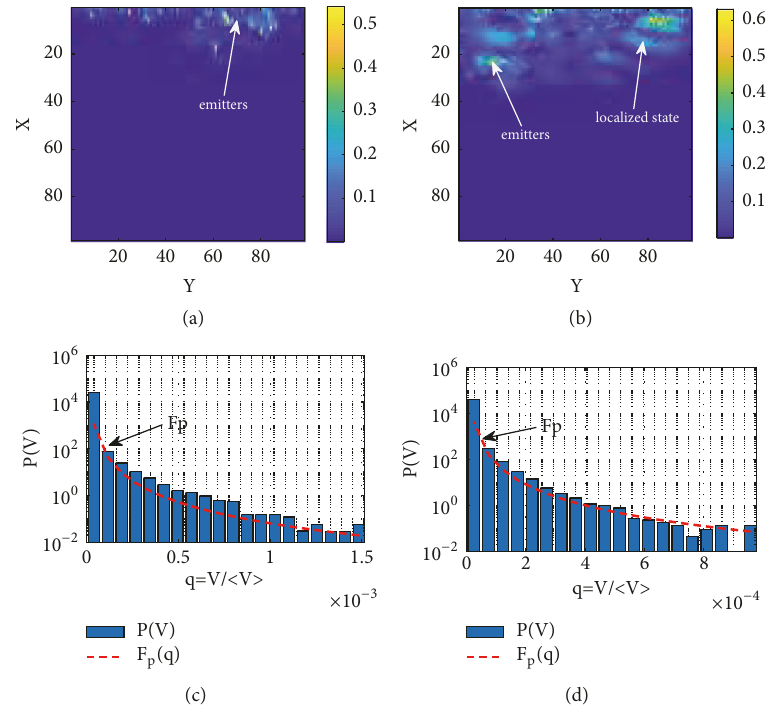
Figure 3: The initial formation of field patterns for time 𝑡 = 5 for optical emitters in a percolating clusters for cases 𝑝 = 0.28 (a,c) and 𝑝 = 0.30 (b,d), respectively. (a) The speckle pattern in a central slice of 3D cube similar to Figure 2(b); (b) the same as (a) but for percolating cluster with larger population 𝑝 = 0.30 . We observe in (a), (b) the radiated emitters (depicted as point-like spots) surrounded by smoothly shaped areas that correspond to weak localized fields; (c) and (d) exhibit corresponding histograms of intensity 𝑉 and the probability density functions (dashed red line) with 𝐹 𝑝 (𝑞) defined by